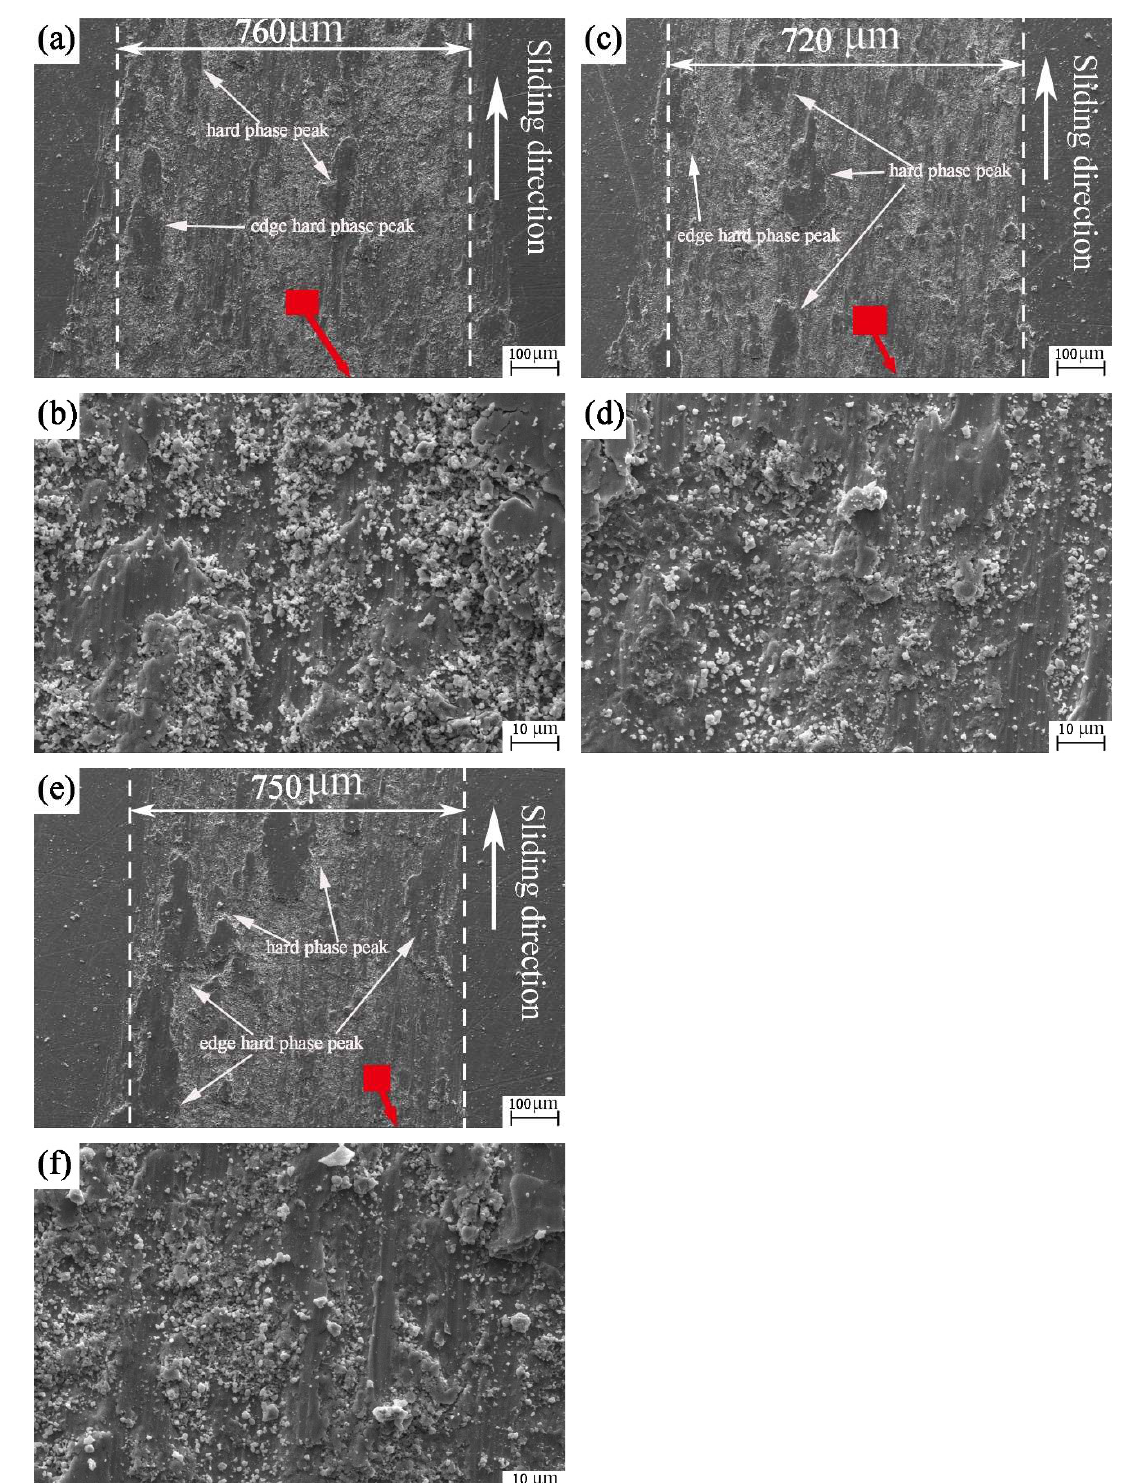
Figure 13. SEM images of the femtosecond-textured worn plates: ( a , b ) Rotation radius 15 mm; ( c , d ) Rotation radius 18 mm; and ( e , f ) Rotation radius 22.5 mm.